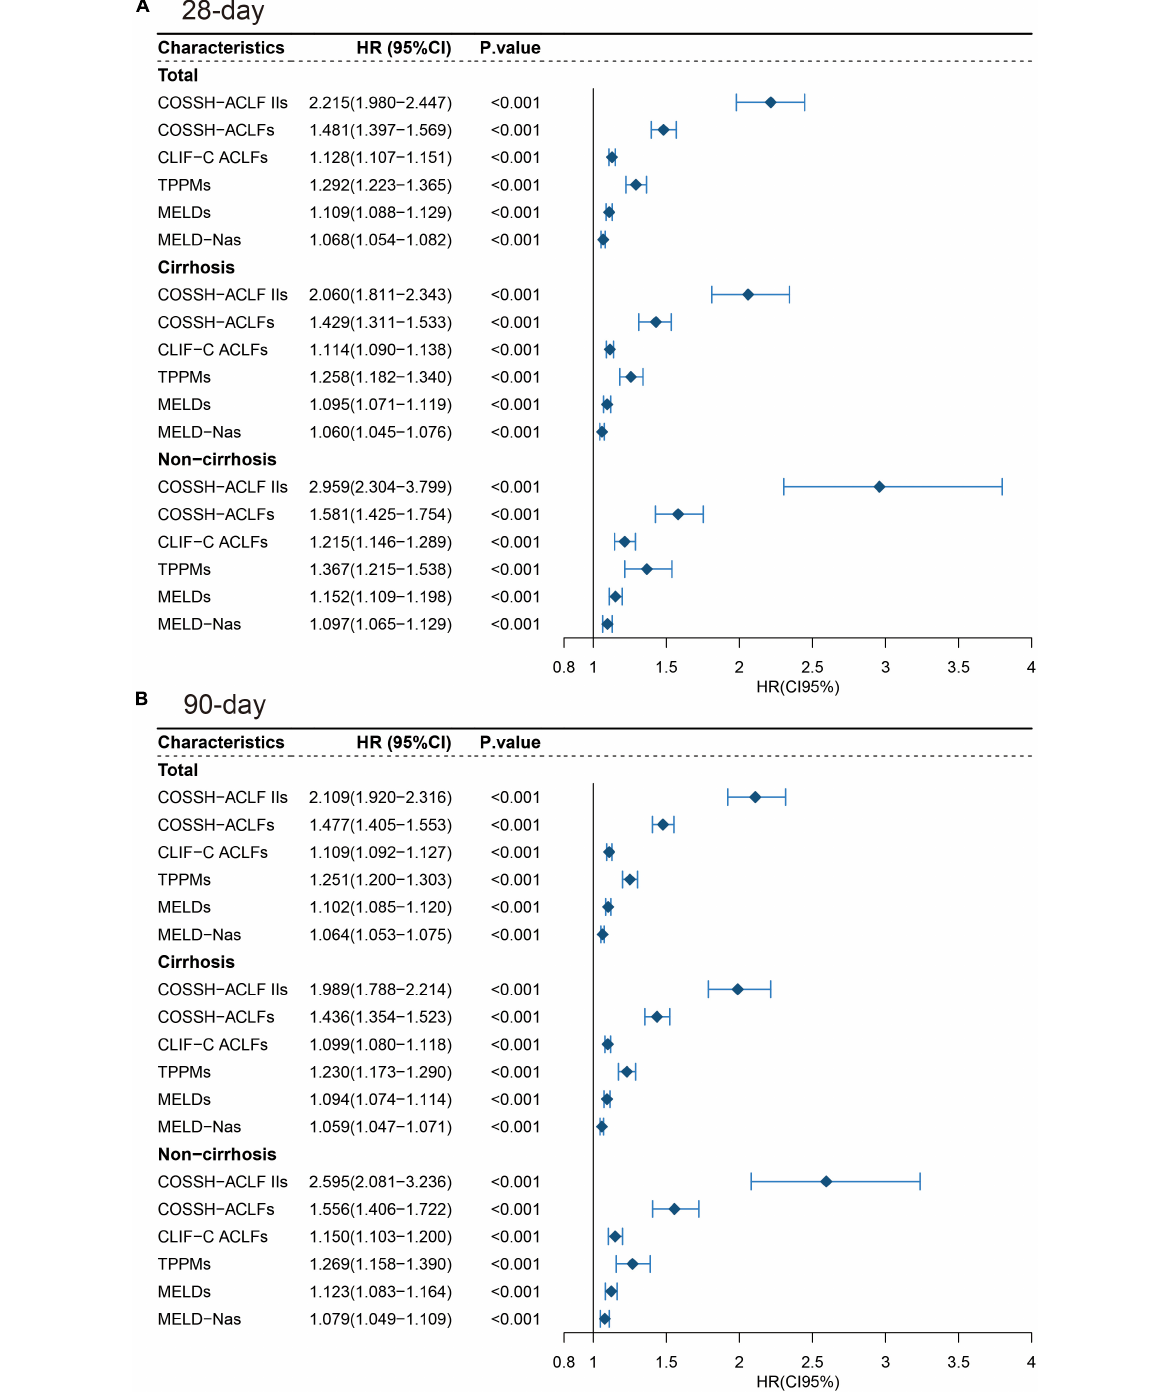
with. The conclusions remained to be unchanged regardless of whether LT was censored, excluded, or combined with death ( Supplementary Tables 1 , 2